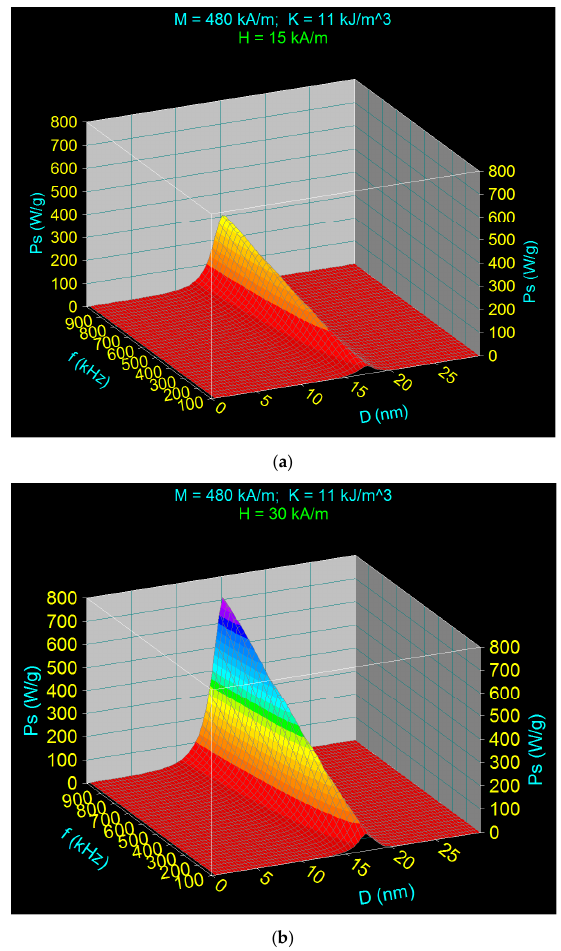
Figure 4. The specific loss power variation according to the Formula (22) depending on the nanoparticle diameter and the AMF frequency for the magnetic field amplitude of ( a ) 15 kA/m and ( b ) 30